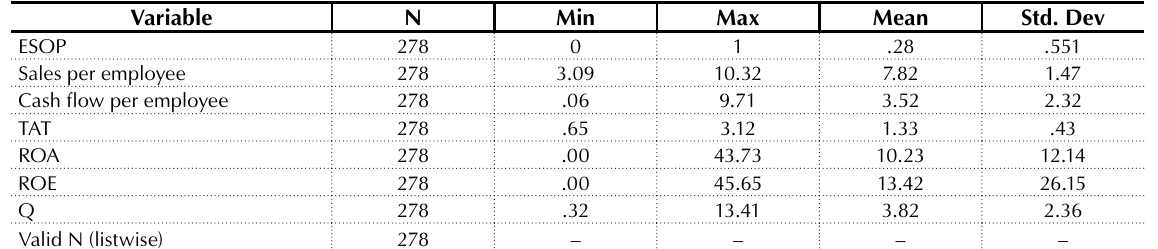
Table 1. Descriptive statistic